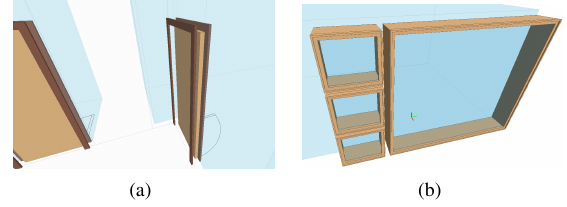
Figure 8: Example of IfcDoors and IfcWindows